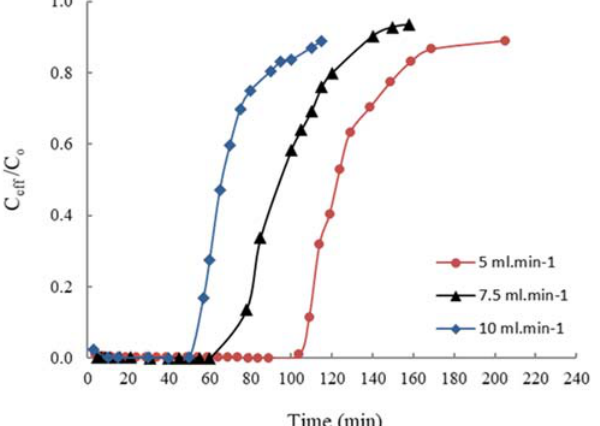
Figure 5. Effects of variable rates of flow on the adsorption’s curve of breakthrough for RHAC (bed depth = 8.5 cm; phenol concentration at inlet = 1000 mg·L − 1 ).